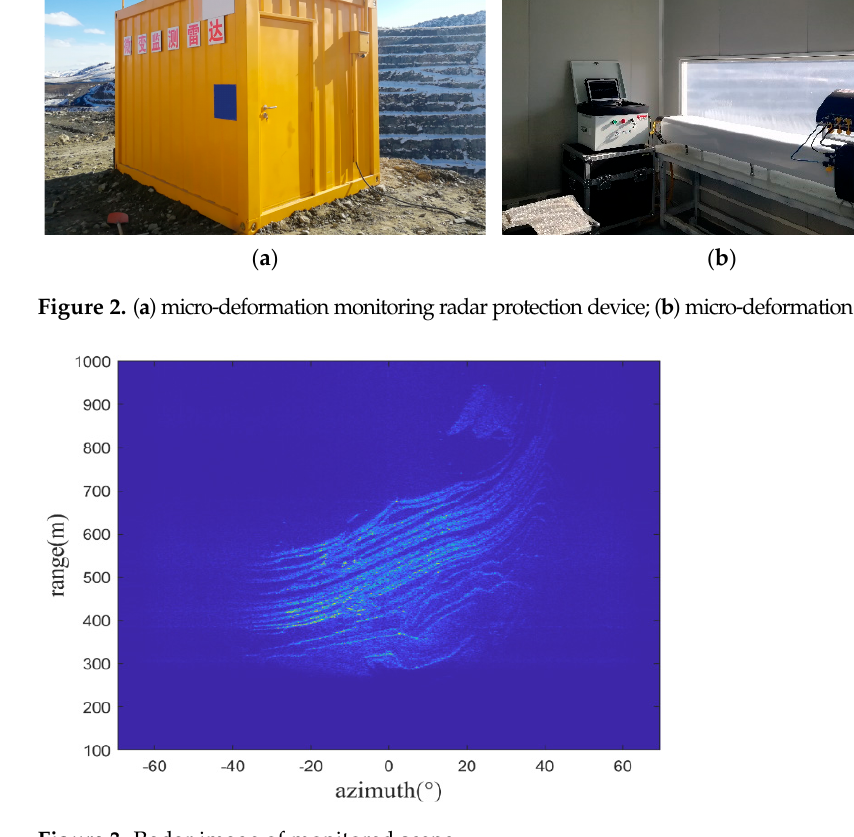
Figure 2. ( a ) micro-deformation monitoring radar protection device; ( b ) micro-deformation moni- toring radar.